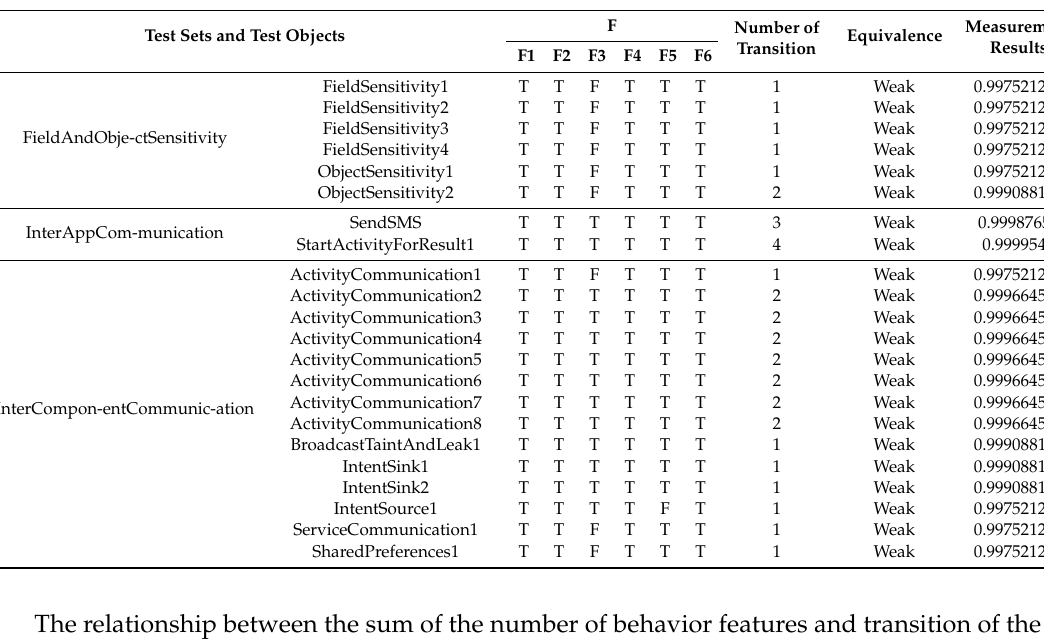
Table 6. Benchmarks results.